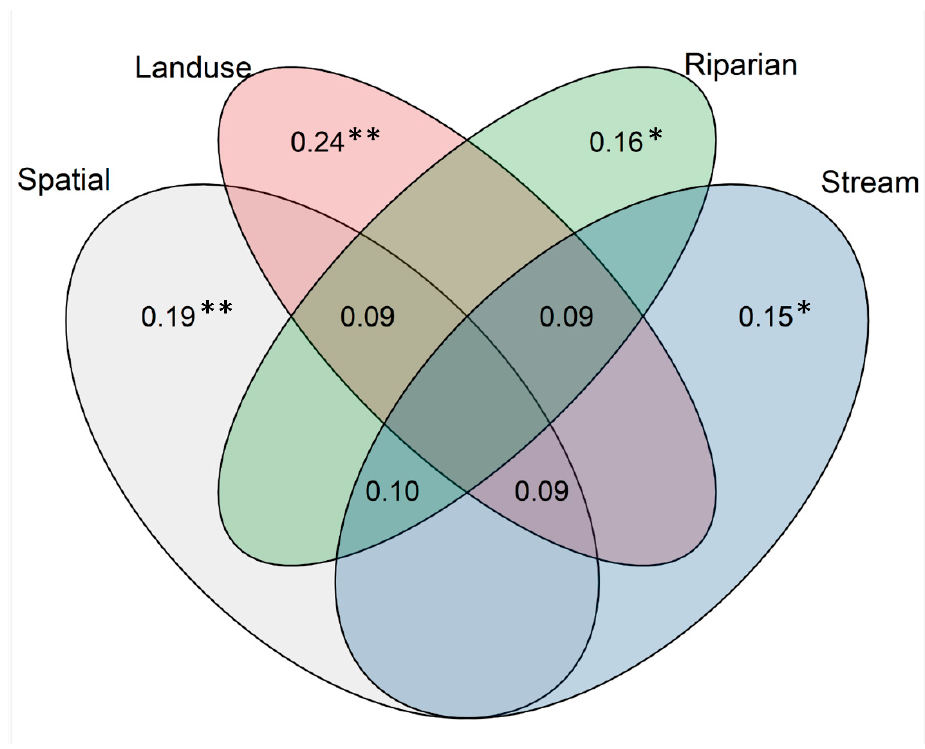
Figure 3. Variation partitioning results showing the portions of variation in diatom community structure explained by different groups of predictors at 10 site pairs in the Oslo basin. The model (PSM2) describes variation in diatom communities explained by Spatial (5 PCNM Axes), Land use (% urban and % agricultural land cover), Riparian (% shrubs and small trees, % lichens and mosses) and Stream factors (% concrete, % aquatic mosses, % boulders, nitrate [mg/L, i.e., water quality]). Values < 0 are not shown. The unexplained (residual) variation was 41%. * p < 0.05, ** p < 0.01 Using the NMDS ordinations, we identified several potential indicator taxa for buffered and unbuffered sites (Figure 4). The indicator species analyses (ISA) revealed influential diatom taxa and potential indicators for the site types. Encyonema minutum (Hilse) D. G. Mann (OMNIDIA